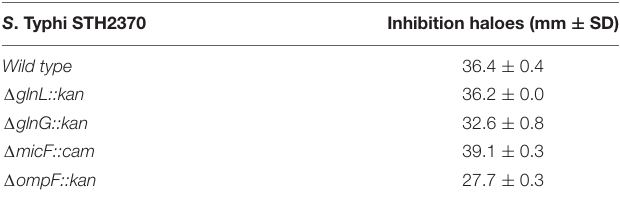
TABLE 4 | Susceptibility to ciprofloxacin of S. Typhi null mutants in genes glnL , glnG , micF, and ompF. S . Typhi STH2370